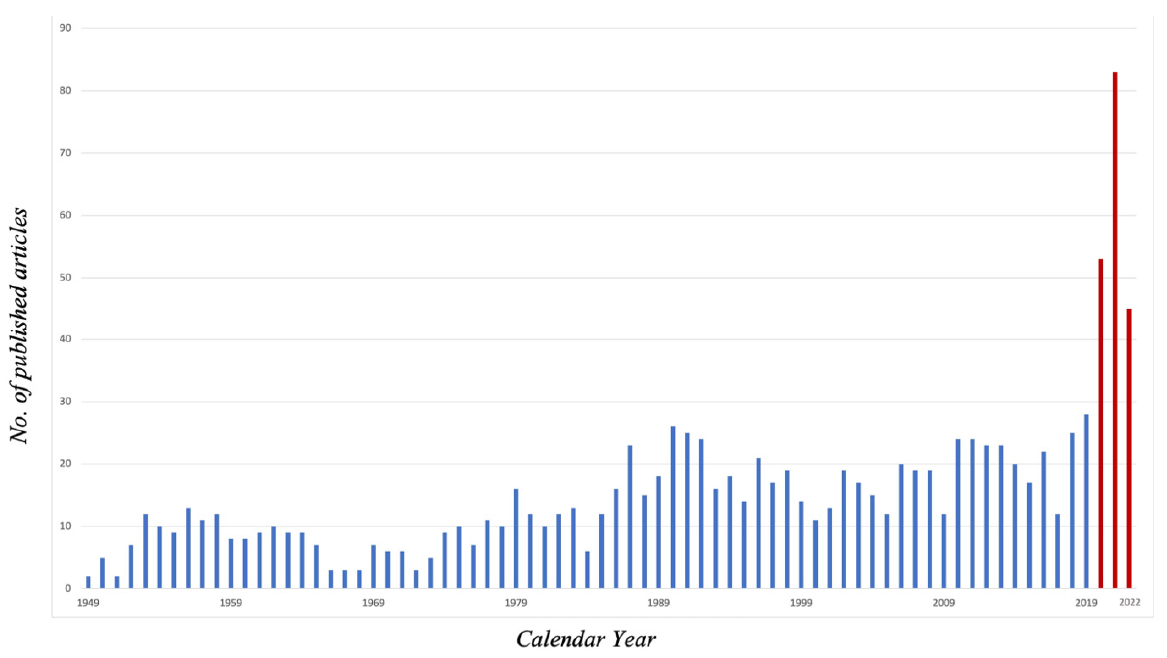
Figure 3. PubMed articles regarding subacute thyroiditis per publication year. Red columns represent years from 2020 to April 2022, since the beginning of COVID-19 pandemic.